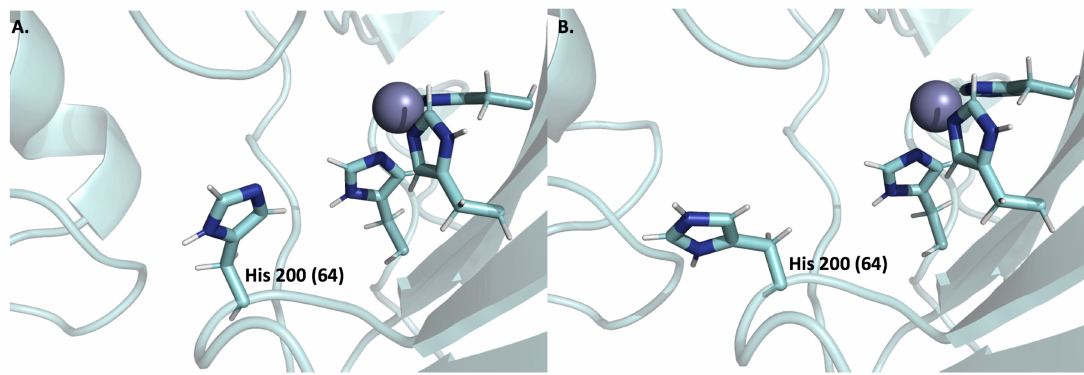
Figure 2. Positions and protonation states of CA IX catalytic His 200 (64 with CA II numbering) that has been implicated in proton sequestration in the acidic tumor microenvironment. ( A ) Deprotonated His 200 (PDB: 4Q49) in an “in” position at neutral pH = 7.5. ( B ) Protonated His 200 (PDB: 4Y0J) in an “out” position at acidic pH (pH = 6.0) representative of a “proton sequestered” state as in the acidic tumor microenvironment. Neutron crystallography structures of CA II were used to determine protonation states and positions and were previously determined by Fisher and McKenna